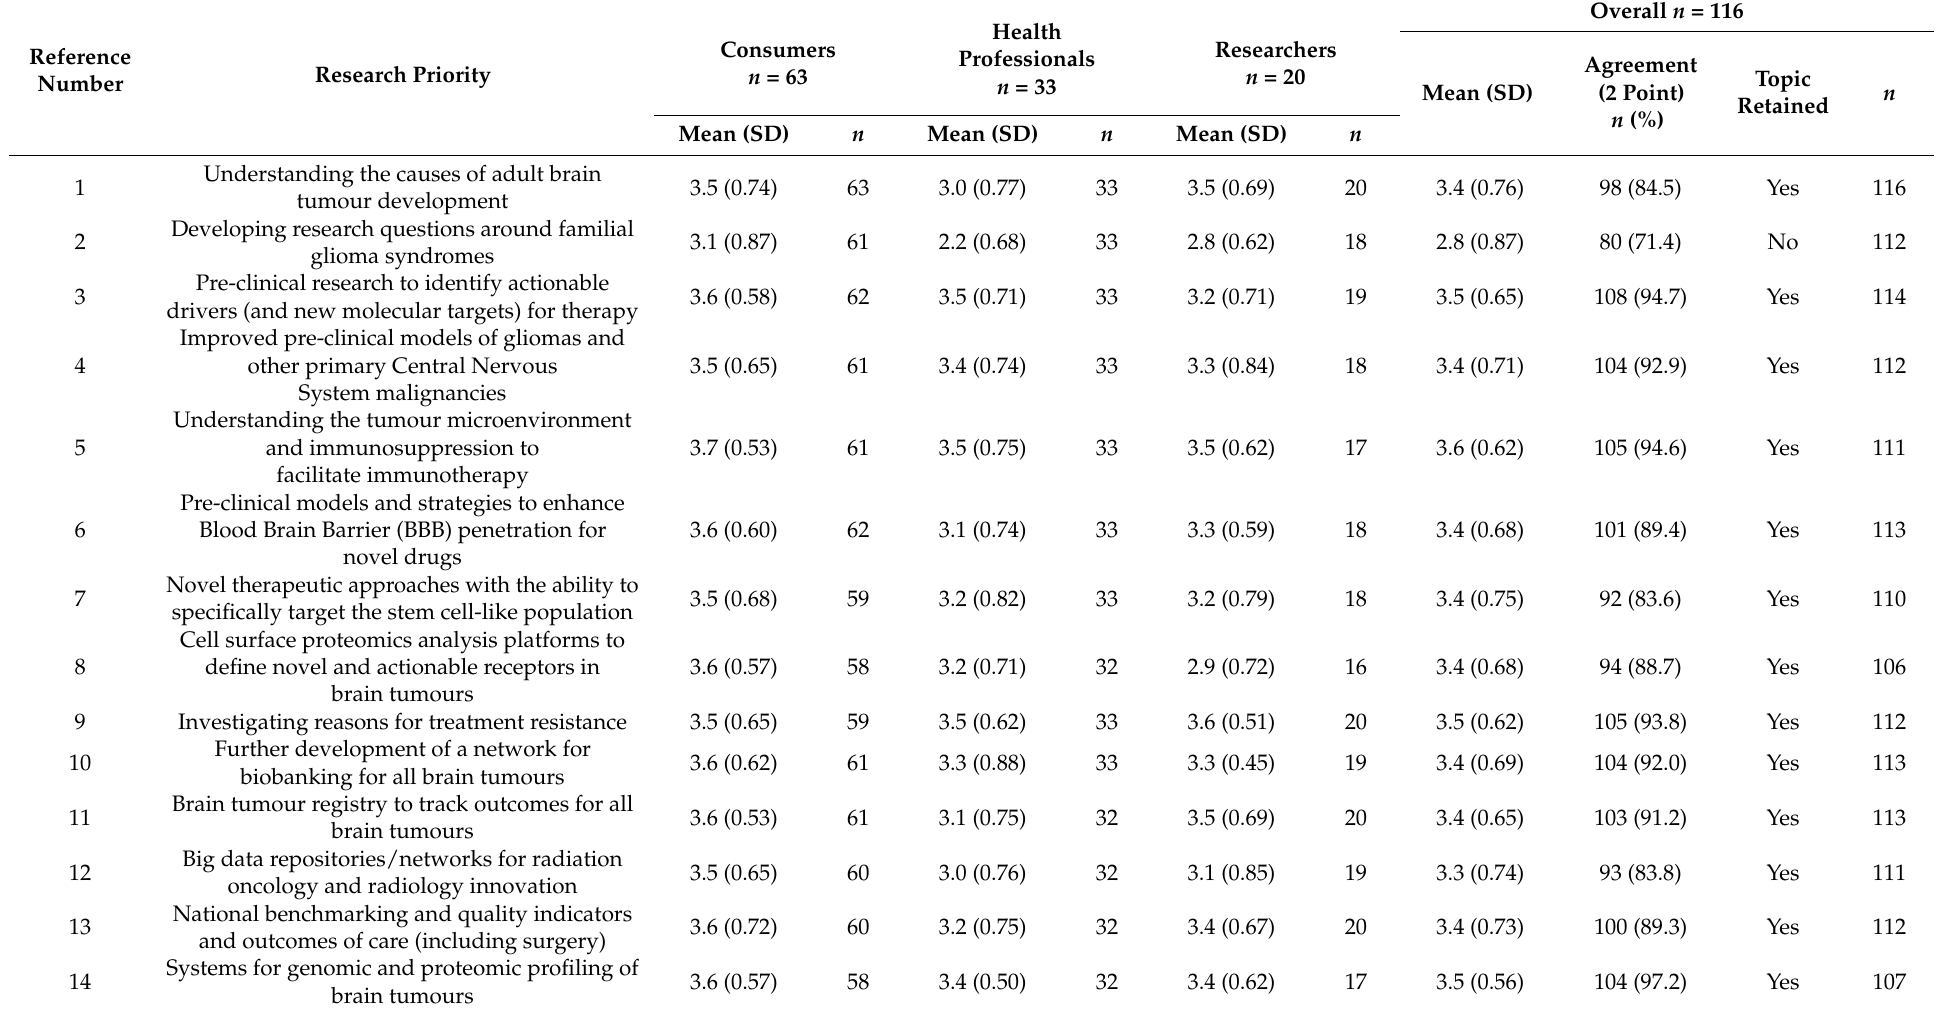
Table 4. Phase 2, Step 1 participants importance ratings and consensus on research